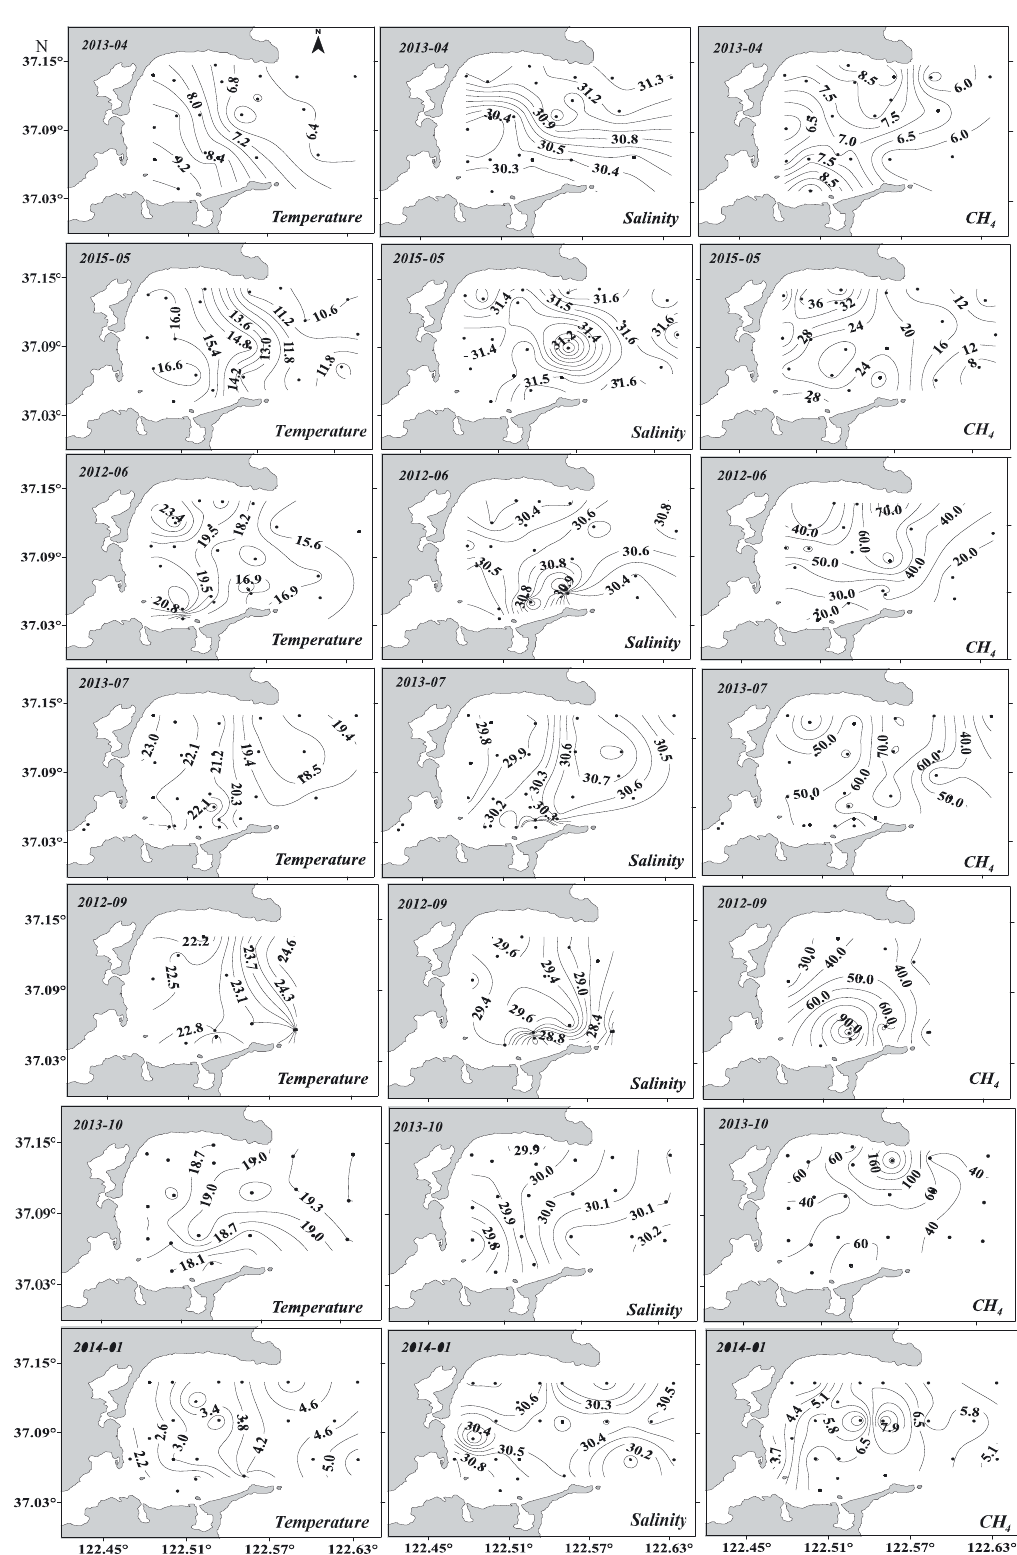
Fig. 3. Geographical distributions of water temperature (°C), salinity, and CH 4 concentration (nM) in surface waters of Sanggou Bay (SGB) during 2012 to 2015 (dates are